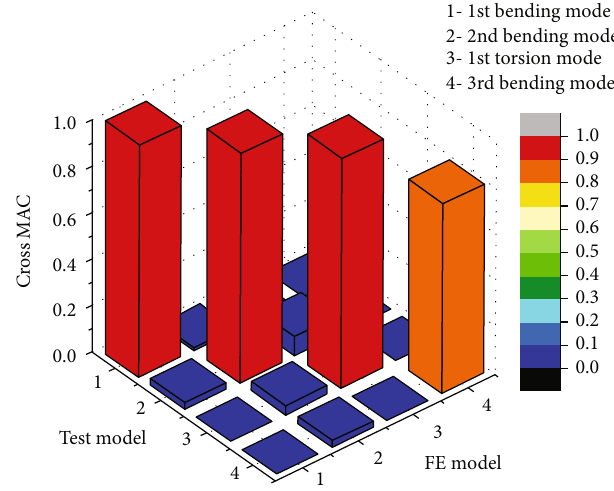
Figure 10: Cross MAC of numerical-experimental